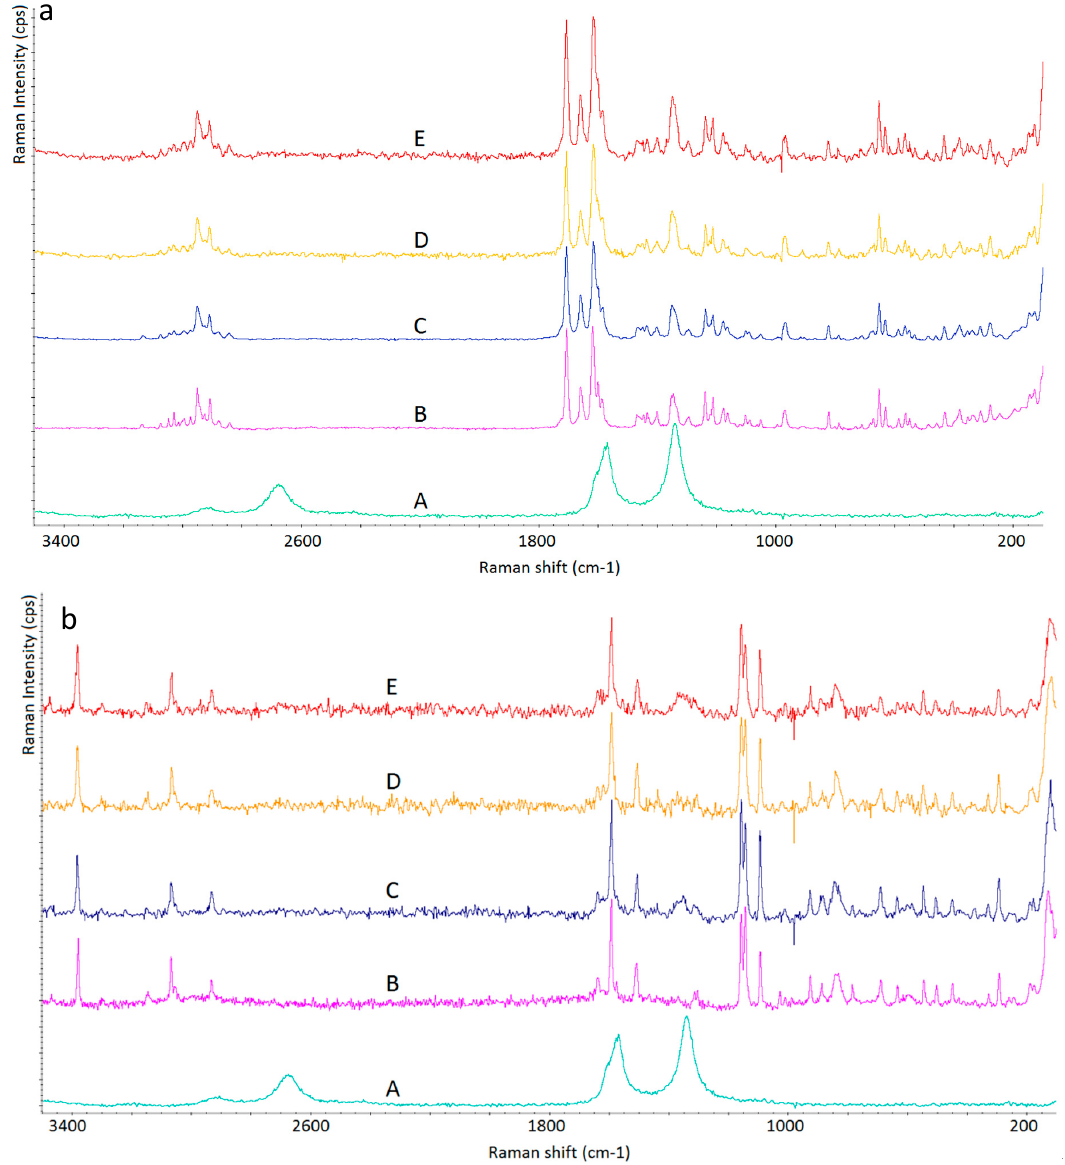
Figure 4. ( a ) Raman spectra of (A) f-CNT 23.2 , (B) pure GF, (C) GF-CNT 23.2 , (D) GF-CNT 19.8 , and (E) GF-CNT 16 ; ( b ) Raman spectrum of (A) f-CNT 23.2 , (B) pure SMZ, (C) SMZ-CNT 23.2 , (D) SMZ-CNT 19.8 , and (E) SMZ-CNT 16 .